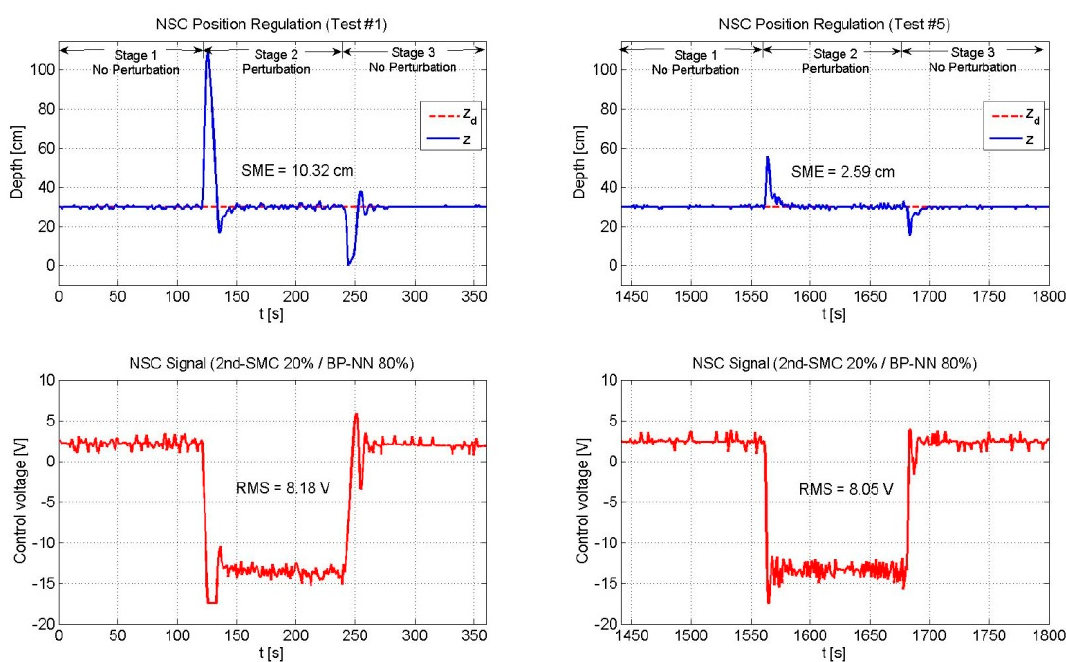
Figure 10. Performance of the NSC scheme (2nd-SMC 20%/BP-NN 80%). The BP-NN scheme appeared as the predominant control with a contribution of 80%. As the neural network adjusted its weights online, the SME decreased in time. The RMS voltage remained practically unchanged.